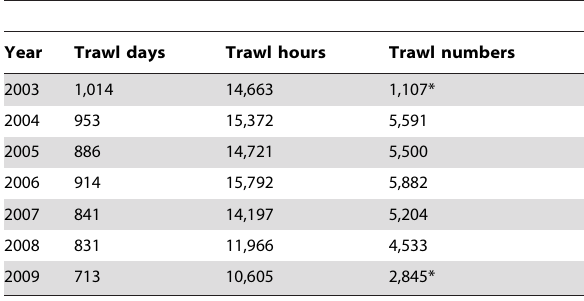
Figure 1. The Pilbara Trawl Fishery off the north-western coast of Australia. Figure includes: a) the 50 and 100 m depth contours; b) the boundaries of the fishery management areas (Areas 1, 2, 4 and 5; Area 3 in the central southern region of the fishery is closed to trawling); c) the spatial density of fishing effort based on logbook trawls; and d) the location of dolphin bycatch events reported in skippers’ logbooks and by independent observers (August 2003 to September 2009). doi:10.1371/journal.pone.0093178.g001 In October 2008, the belly and neck sections of the nets were shortened to allow for a shorter escape route for dolphins that enter the net and interact with the exclusion grid (Fig. 2). Based on stretch mesh measurements, the nets are approximately 44 m long from the footrope to the start of the codend and, when trawling/ fishing, they are likely to be about 60–70% of this length. Table 1. Total numbers of trawl days, hours and individual trawls in the